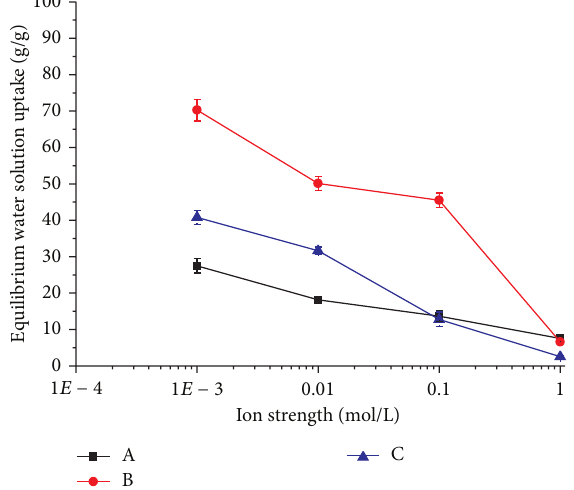
Figure 4: Hydrogels equilibrium swelling properties in water solution at different ionic strength. Reported values have been aver- aged over five measurements ( 𝑛 = 5 ).